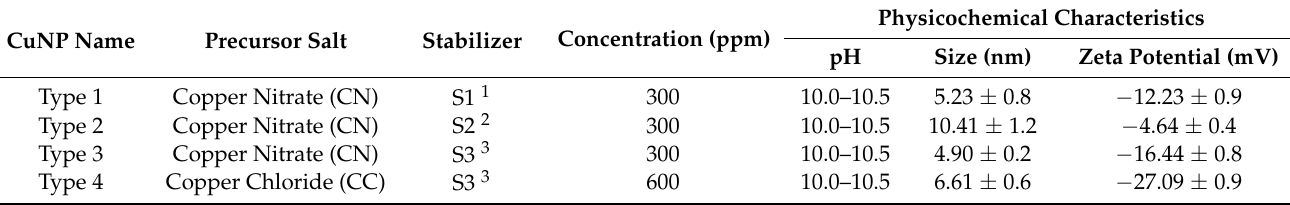
Table 1. Cu-NP species/types based on the employed synthesis route and their physicochemical